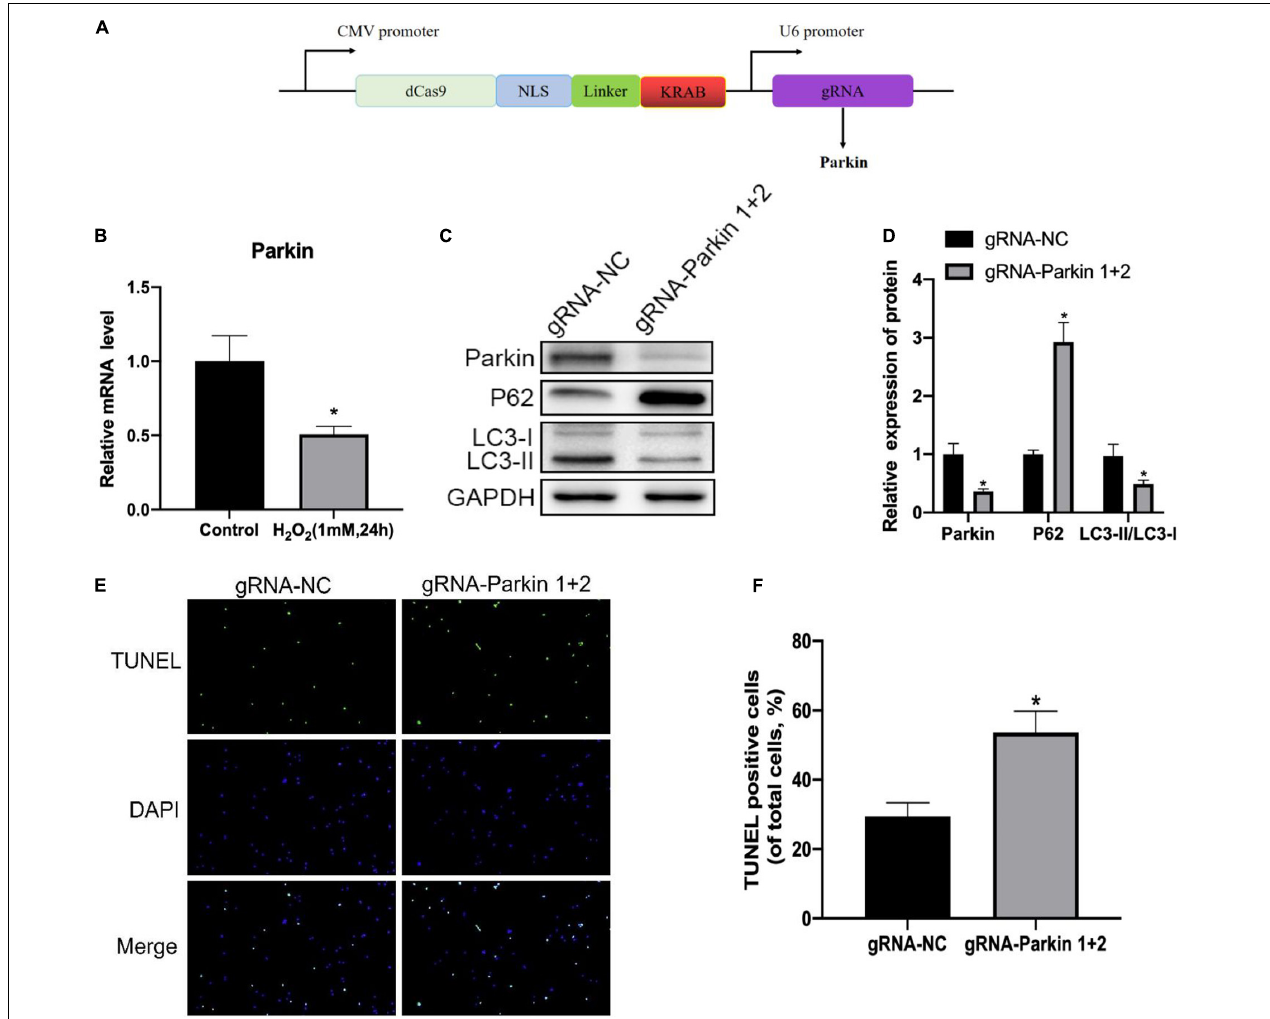
FIGURE 6 | Inhibition of Parkin by the dCas9-KRAB system significantly attenuates H 2 O 2 -induced mitophagy. (A) Vector map of clustered regularly interspaced palindromic repeat epigenome editing vectors targeting the Parkin gene promotor region. (B) Expression level of Parkin in NP cells. (C,D) Western blot of Parkin, P62, LC3-I, and LC3-II expression in NP cells after Parkin inhibition. (E,F) Representative images of TUNEL staining and quantitative analysis showing NP cells apoptosis after Parkin inhibition. * p < 0.05 vs. control